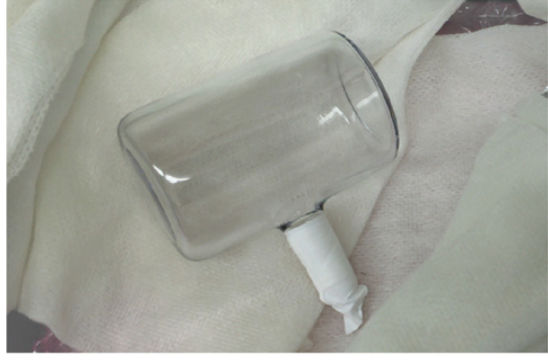
Figure 2. The 3 He gas cell.